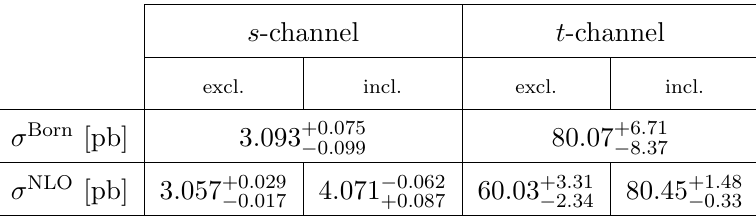
Table 1 . Fiducial cross